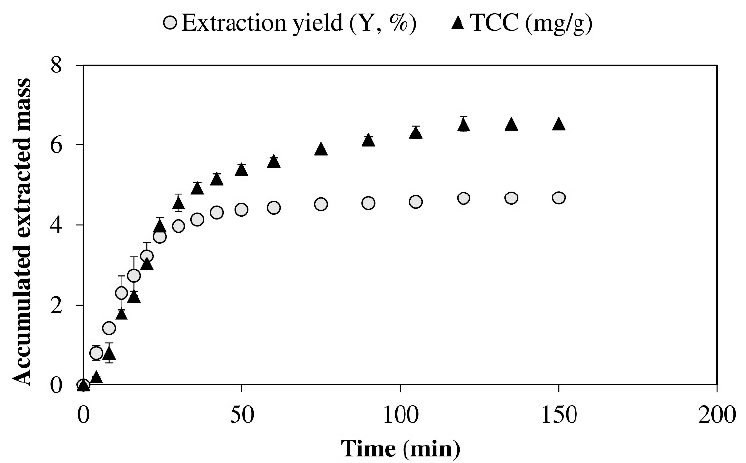
Figure 2. Kinetics of improving extraction yield (Y, %) and total carotenoids content (TCC) from I. galbana during 150 min. The working conditions were at the central point: 50 ºC, 30 MPa, 4% co- solvent (ethanol, v/v), and a CO 2 flow rate of 7.2 g/min.